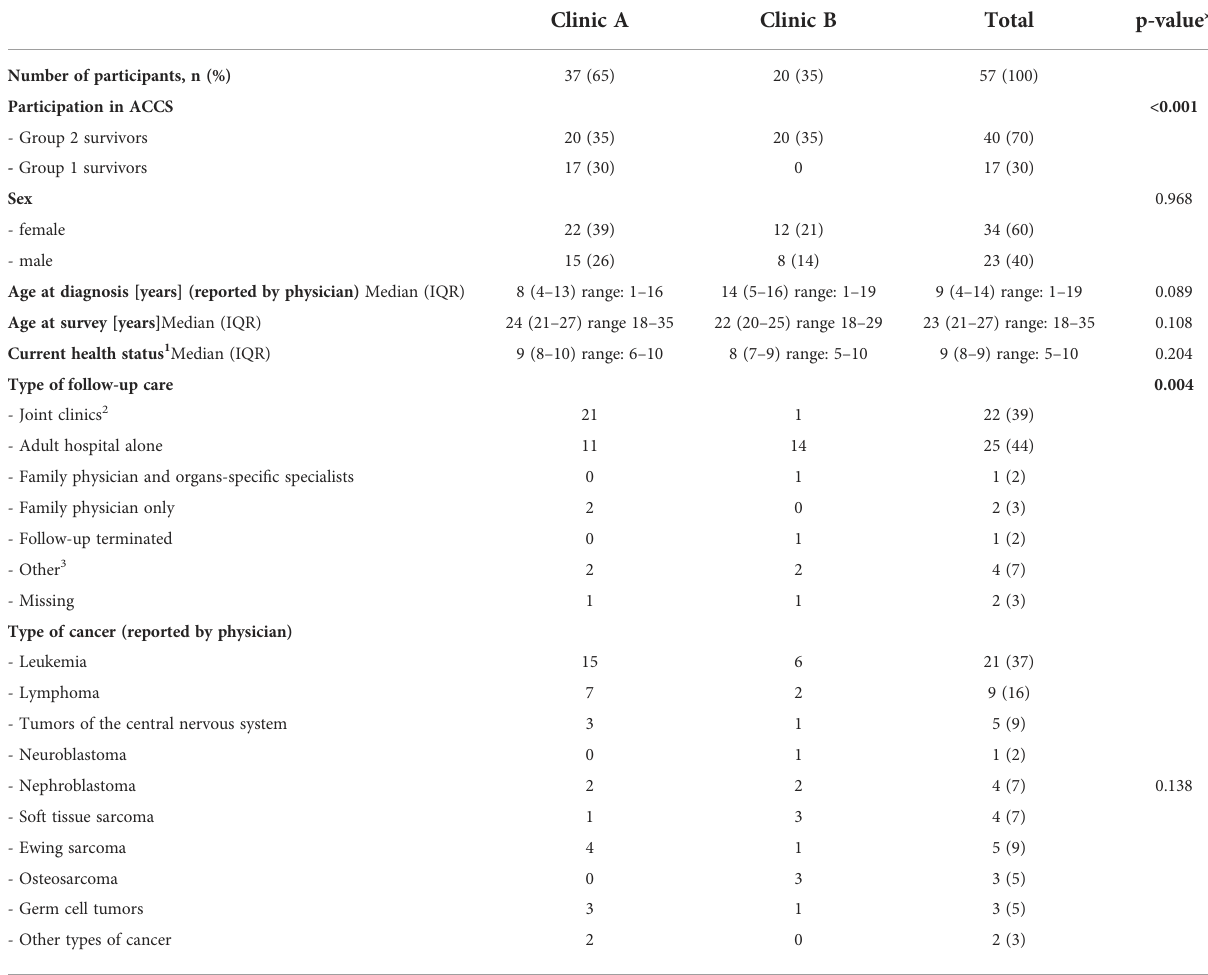
Joint clinics combine pediatric and adult disciplines for long-term follow-up care. 3 Orthopedists only, moved abroad, unsure about the current situation.